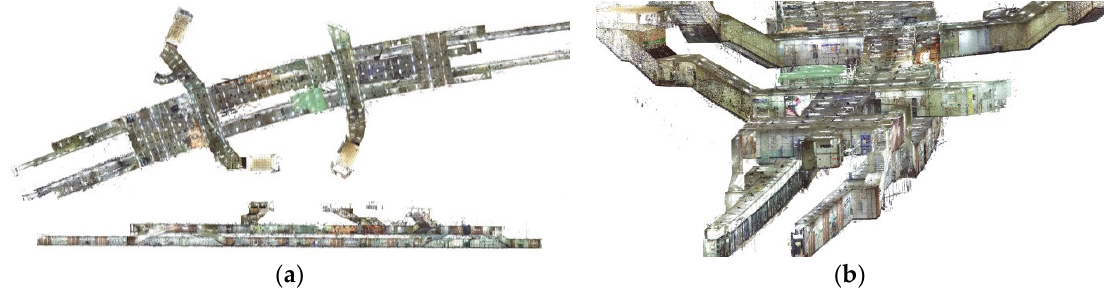
Figure 8. ( a ) Prospectic views; and ( b ) 3D view of the complete point cloud of Bangbae station.